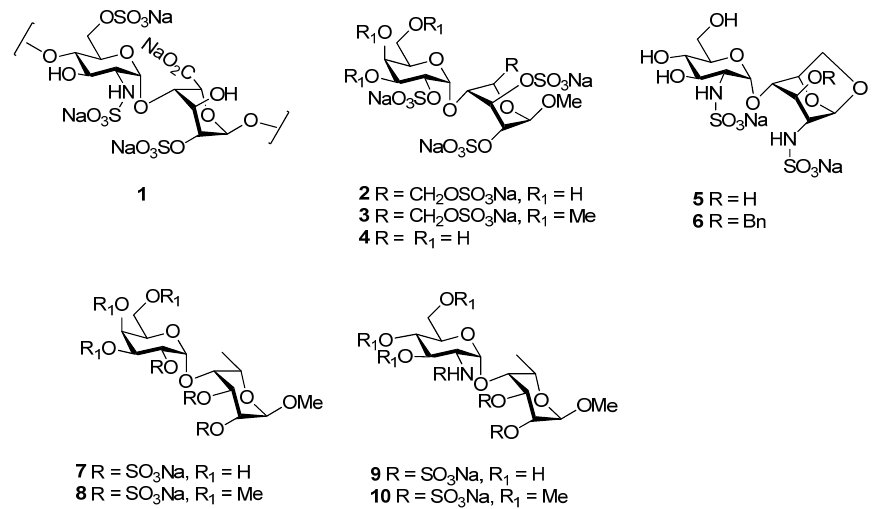
Figure 1. Structures of the GlcN( 2S , 6S )-IdoA( 2S ) disaccharide sequence 1 , which represents a minimal consensus sequence for FGF:HS binding [20], conformationally flexible mimetics 2 – 4 [18], conformationally locked mimetics 5 and 6 [19], and proposed disaccharides of intermediate flexibility 7 – 10